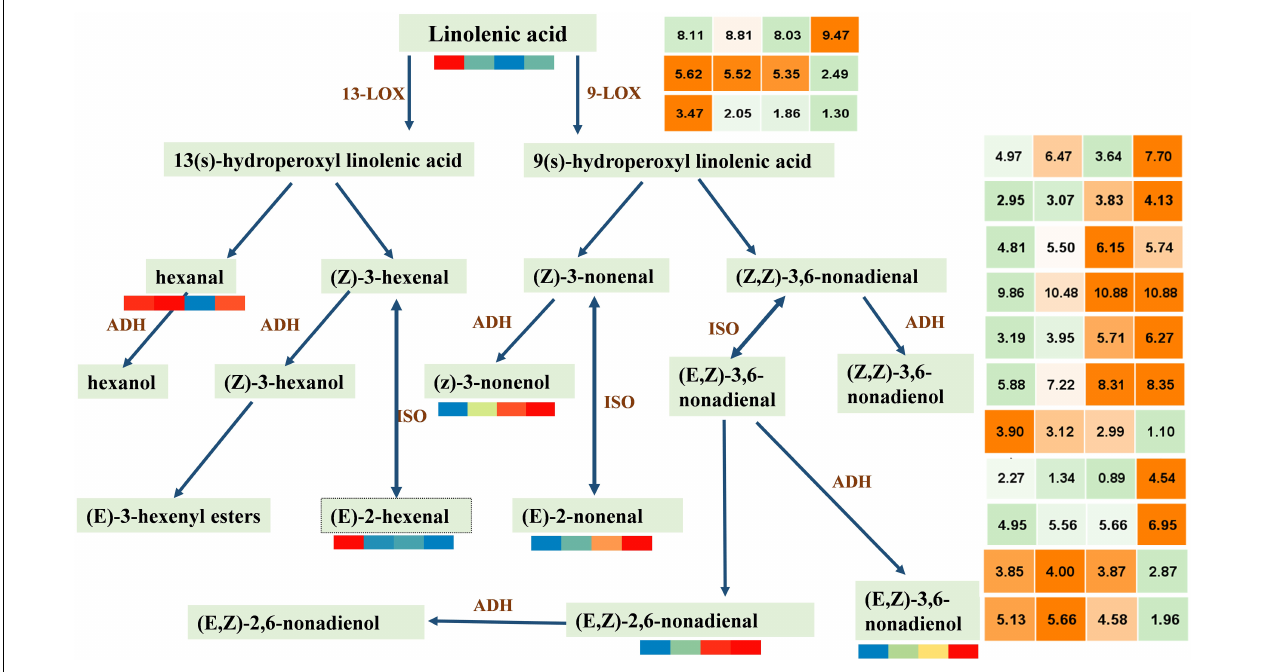
FIGURE 5 | Accumulation patterns of C6 and C9 alcohols/aldehydes synthesized by lipoxygenase pathway and expression patterns of key genes. LOX, lipoxygenase; ADH, alcohol dehydrogenase; ISO, isomerase. In the color scale, each cube metabolized the average of three replicates in the same period. The metabolite data were standardized by the logarithm of 10, and the gene was the logarithm of 2; red and orange represent a higher relative content, and blue represents a lower relative content. From left to right represents the average relative expression of metabolites at 10, 18, 26, 34 DAP, respectively. The gene expression profile information is shown in Supplementary Table 6